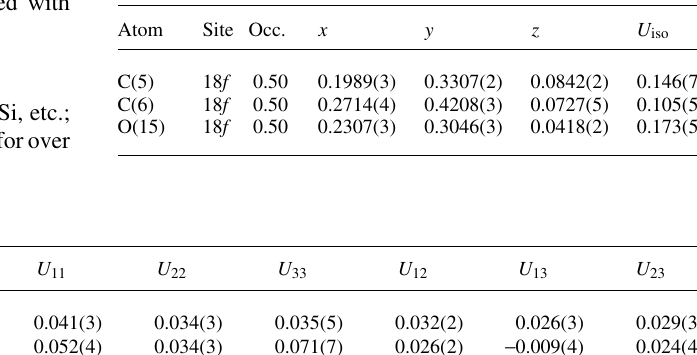
Table 2. Atomic coordinates and displacement parameters (in Å 2 )